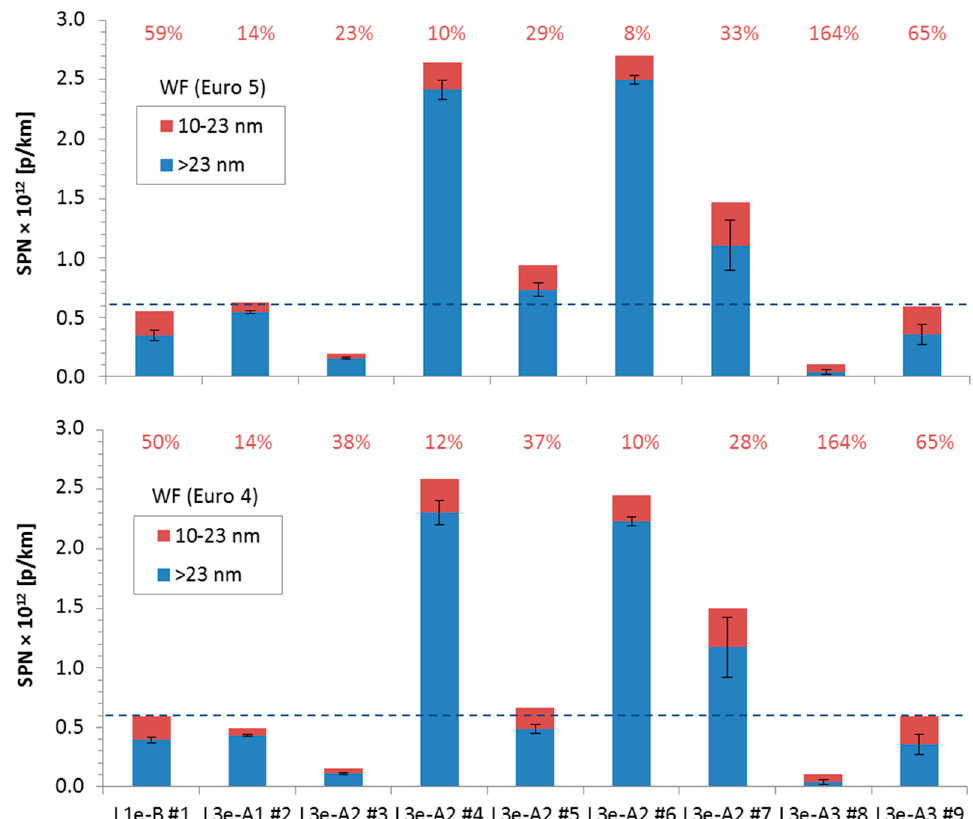
Figure 4. Solid particle number (SPN) emissions. The cycle tested was the WMTC (Figure 2) with the Euro 5 (upper panel) and Euro 4 (lower panel) weighting factors (WF) of Table 2. Exception: L1e-B Euro 4 test cycle was from UNECE Regulation 47. The dashed line shows the SPN > 23 nm limit for diesel and gasoline direct injection passenger cars. Percentages on top show the additional particles that reside below 23 nm (Equation (1)). By applying the Euro 5 weighting factors (upper panel), 4 out of 9 exceed the SPN > 23 nm limit for passenger cars. Three more PTW were close to the limit when the sub-23 nm particles